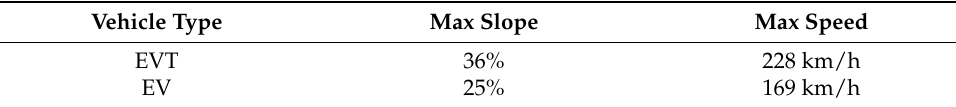
Table 4. Maximum climbing slopes and vehicle speeds of EVT and